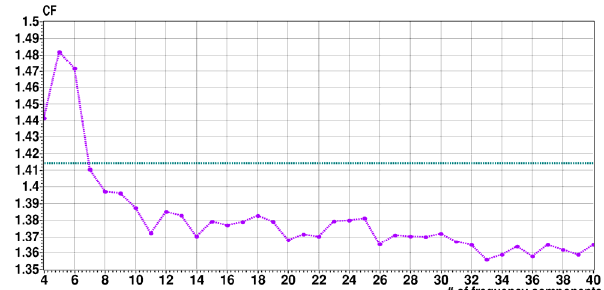
Fig.12: CF of the optimized multisine signal with a consequent frequency distribution ( i = 1,2,3,4 …. k ), for a k in the range from 4 to 40. A green line level corresponds to the CF of a single sine